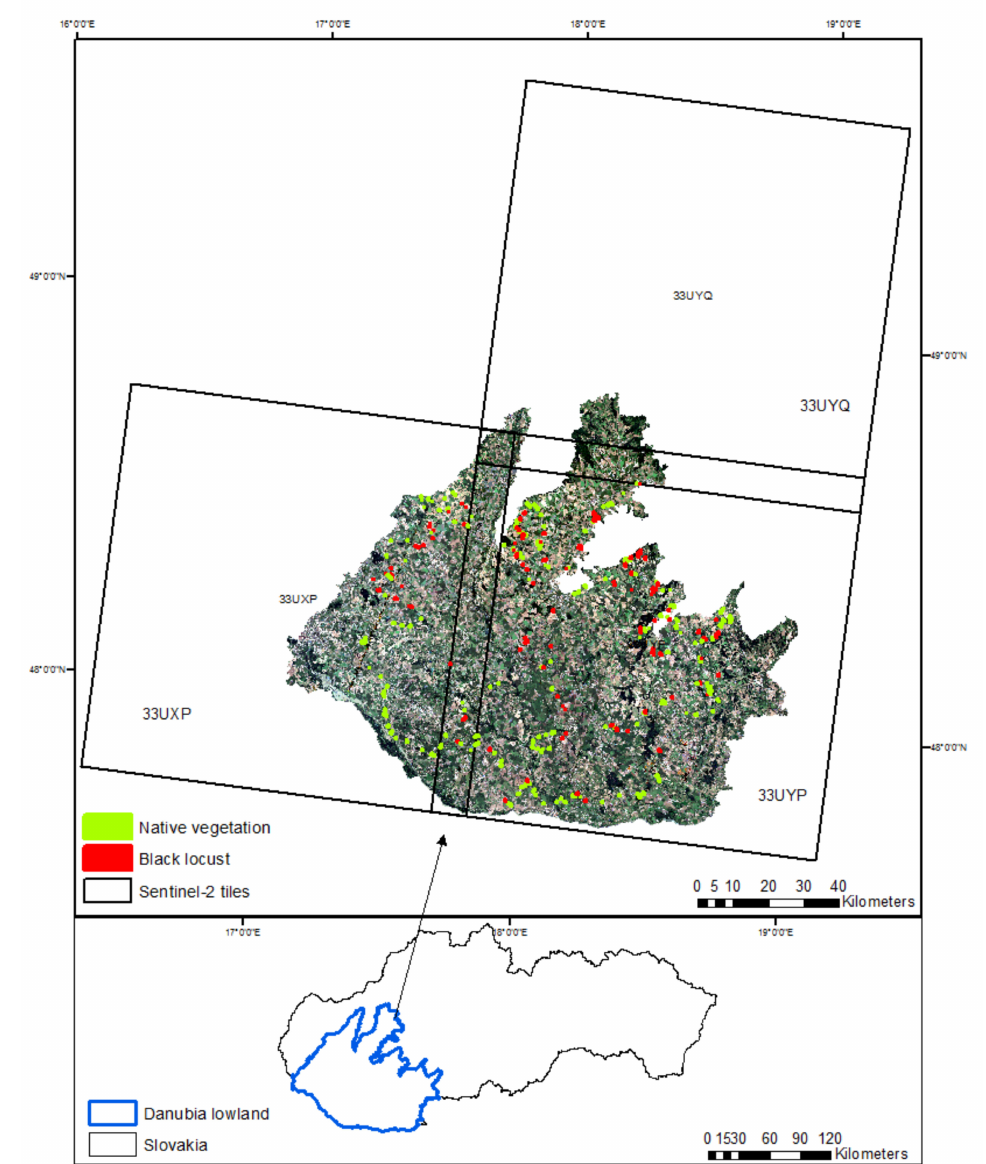
Figure 1. Study area and distribution of the field-based reference sites